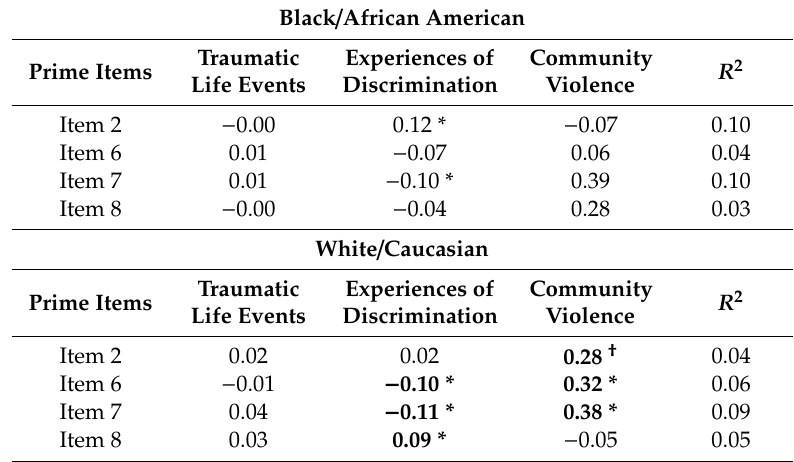
Table 6. Multivariate Linear Regression Models predicting Poor Fit Prime Screen Item Scores. Black / African American Traumatic Experiences of Prime Items Life Events Discrimination